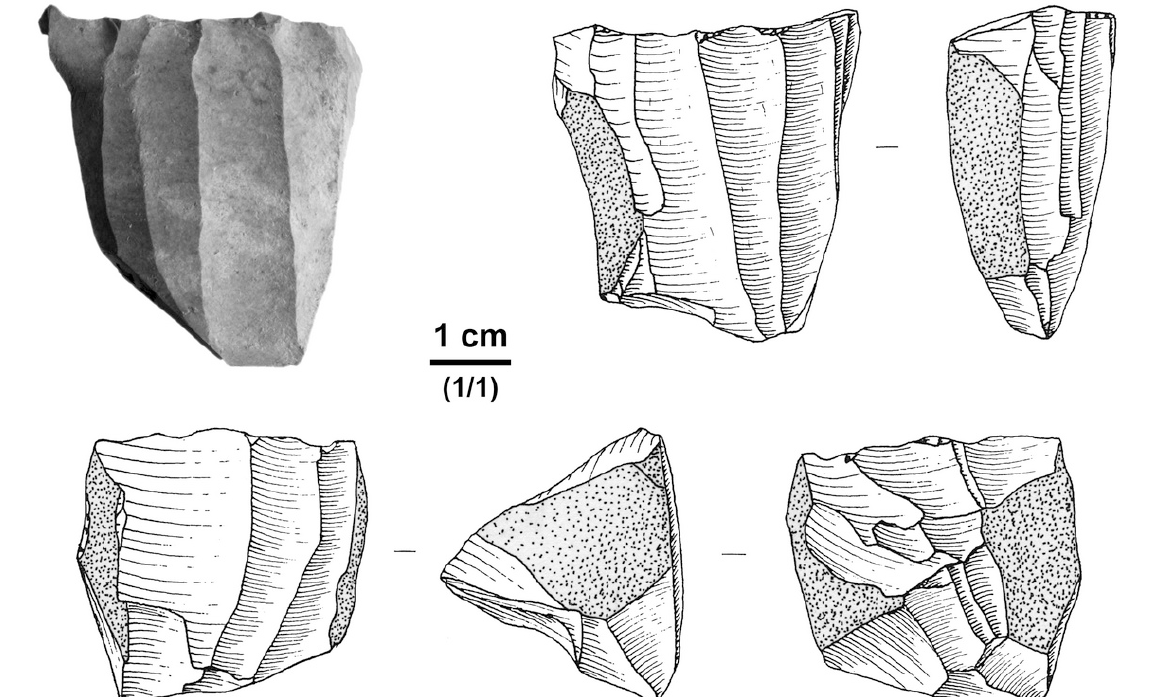
Figure 6. Ruffey-sur-Seille « A Daupharde ». Nucléus avec une surface lamellaire quadrangulaire (Seara et al. 2002: fig. 82 et 83 et Séara 2014). Figure 6. Ruffey-sur-Seille «A Daupharde». Core with a quadrangular lamellar surface (Seara et al. 2002: figs. 82 and 83; Seara